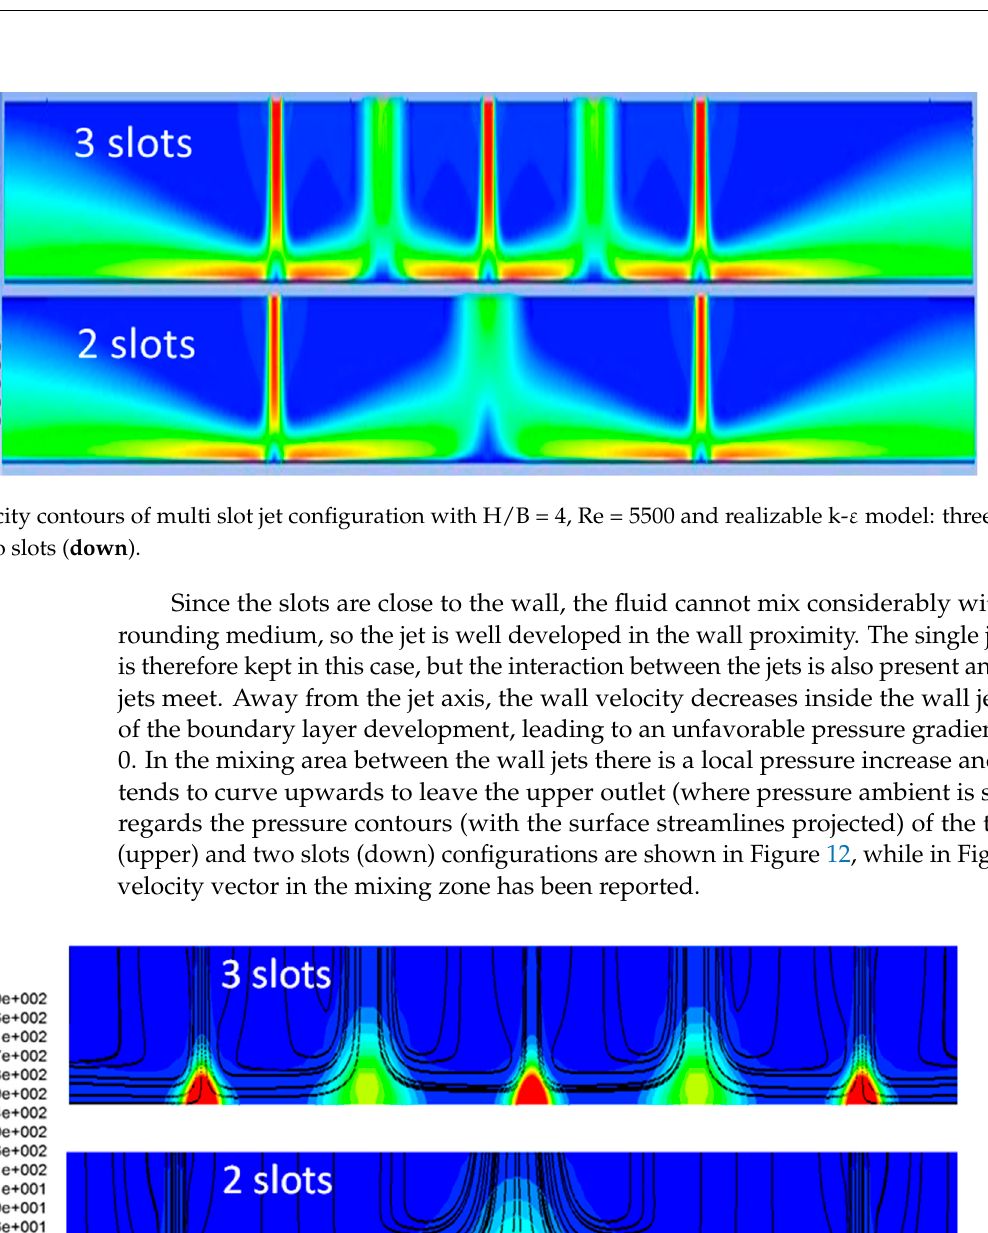
Figure 13. Velocity vector focus on the meeting zone between two wall jets.